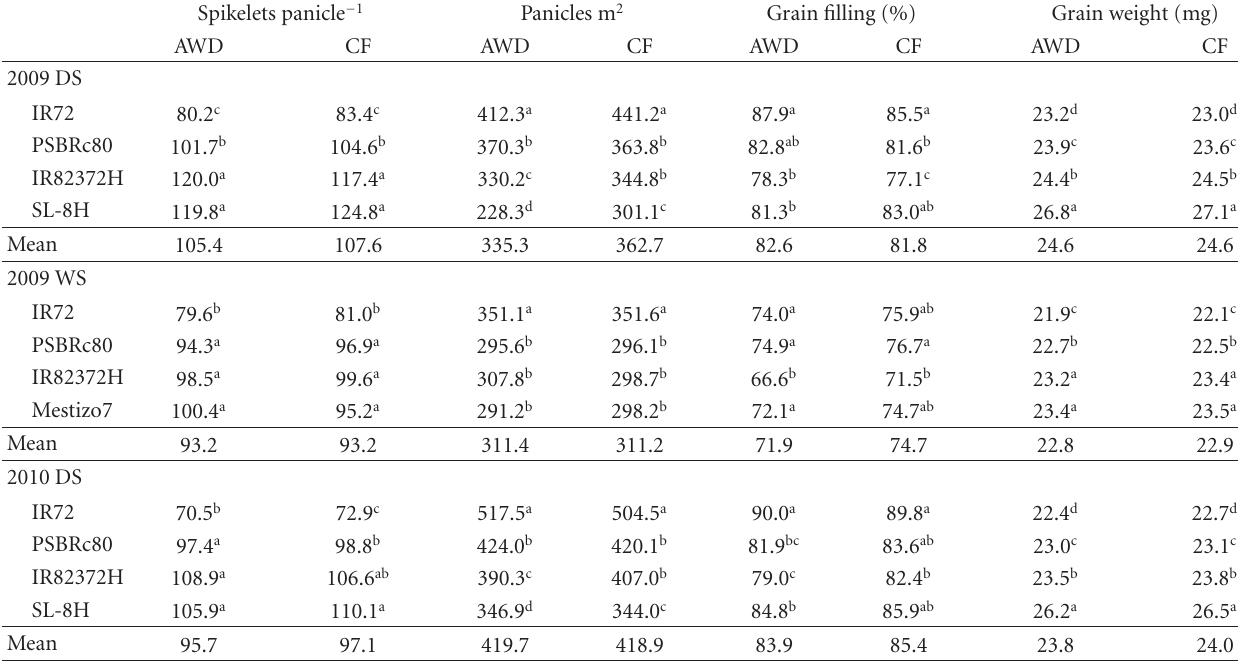
Table 4: Yield components of the four rice varieties grown under two water management treatments and two N rates at the IRRI farm for the three consecutive seasons.